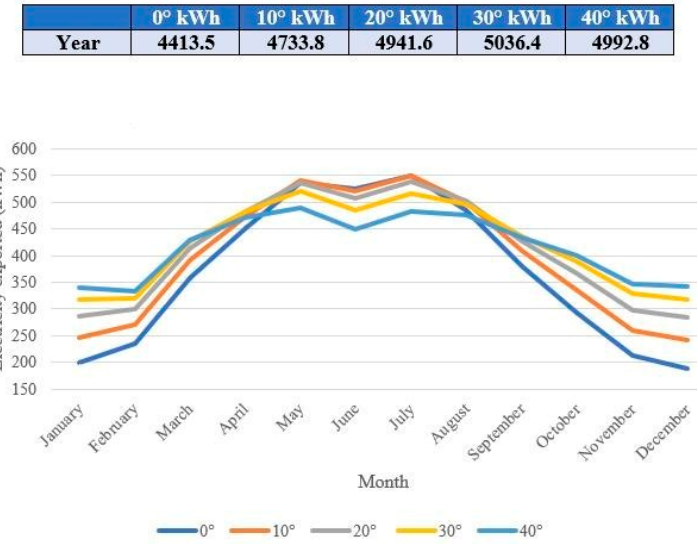
Figure 6. Monthly electricity generation of a 3 kWp south-facing PV system installed with different inclination angles.